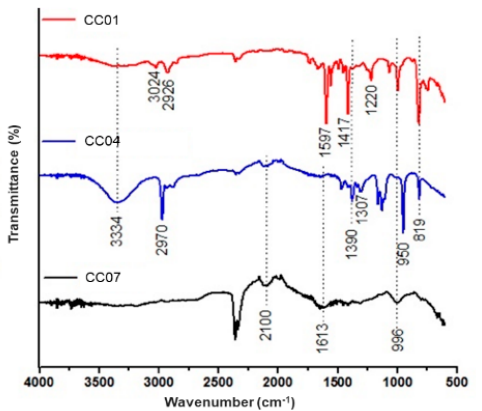
Figure 7. FTIR spectra of CC01, CC04, and CC07 copolymer matrices.